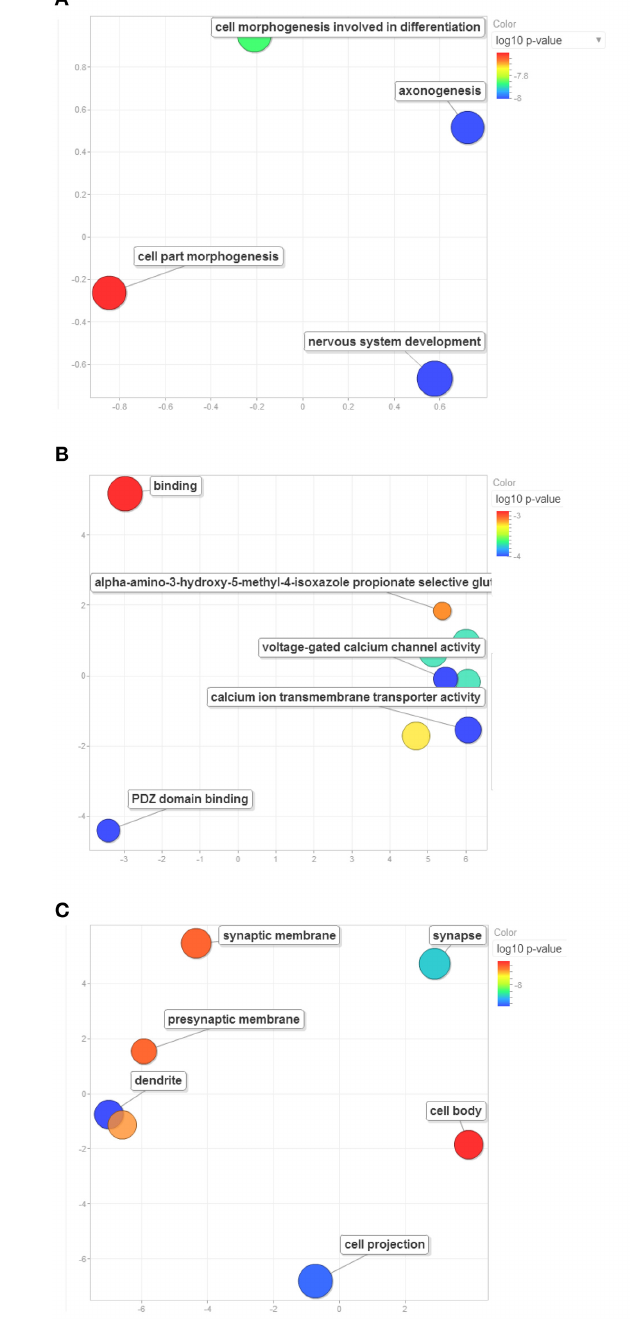
and y coordinates were derived by applying multidimensional scaling to a matrixoftheGOterms’semanticsimilarities;consequently,theirclosenesson the plot should closely reflect their closeness in the GO graph structure i.e. the semantic similarity. GO terms are based on the Gene Ontology Consortium available at: http://www . geneontology . org/. GO enrichment analysis was performed using WebGestalt: an integrated system for exploring gene sets in various biological contexts (Zhang et al., 2005), available at: http://bioinfo . vanderbilt .